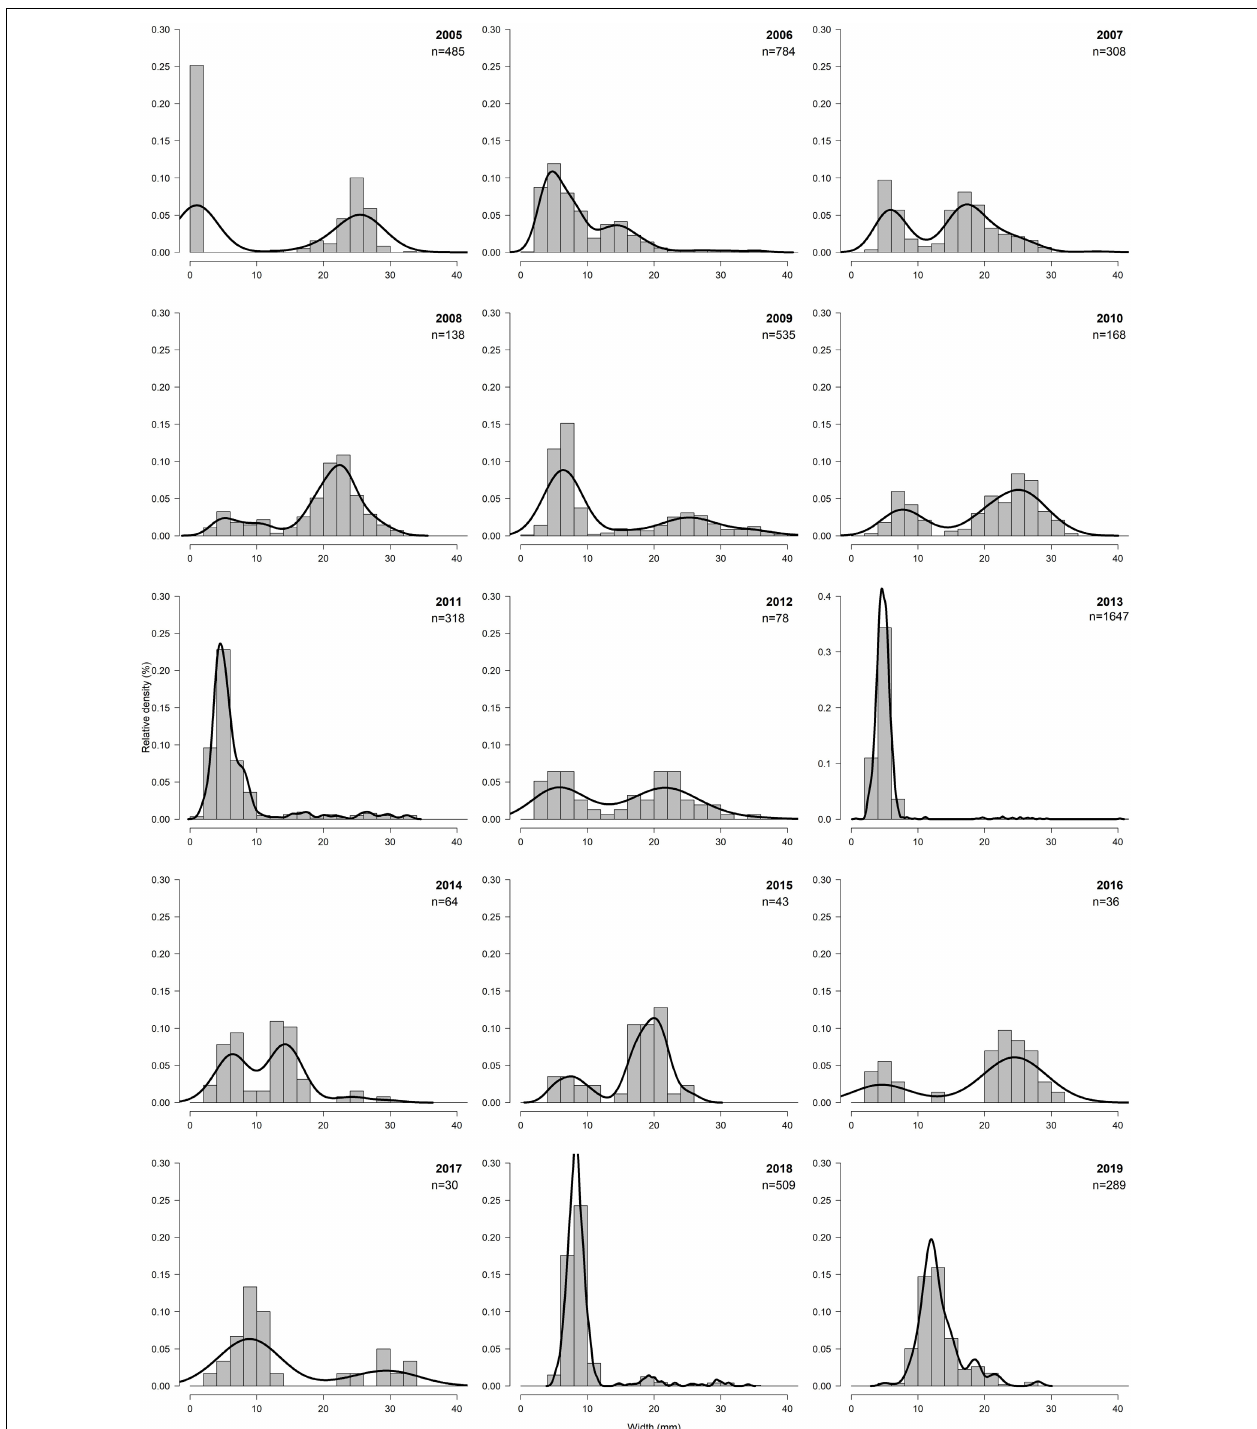
FIGURE 8 | Relative density (%) of size classes of transect M between 2005 and 2019.